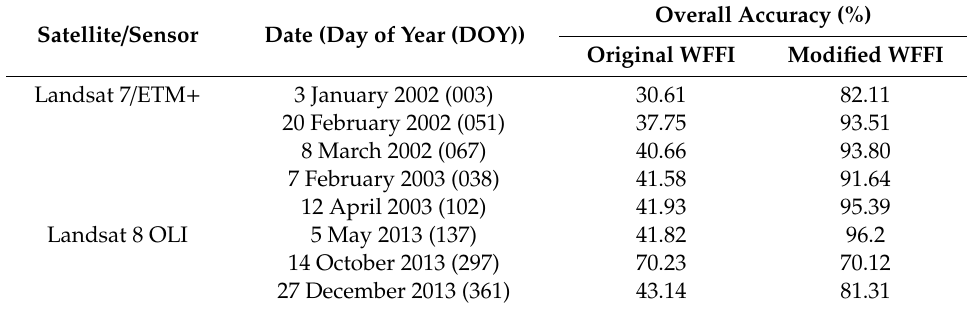
Table 1. Estimated accuracy of the WFFI product relative to the inundation area derived from Landsat